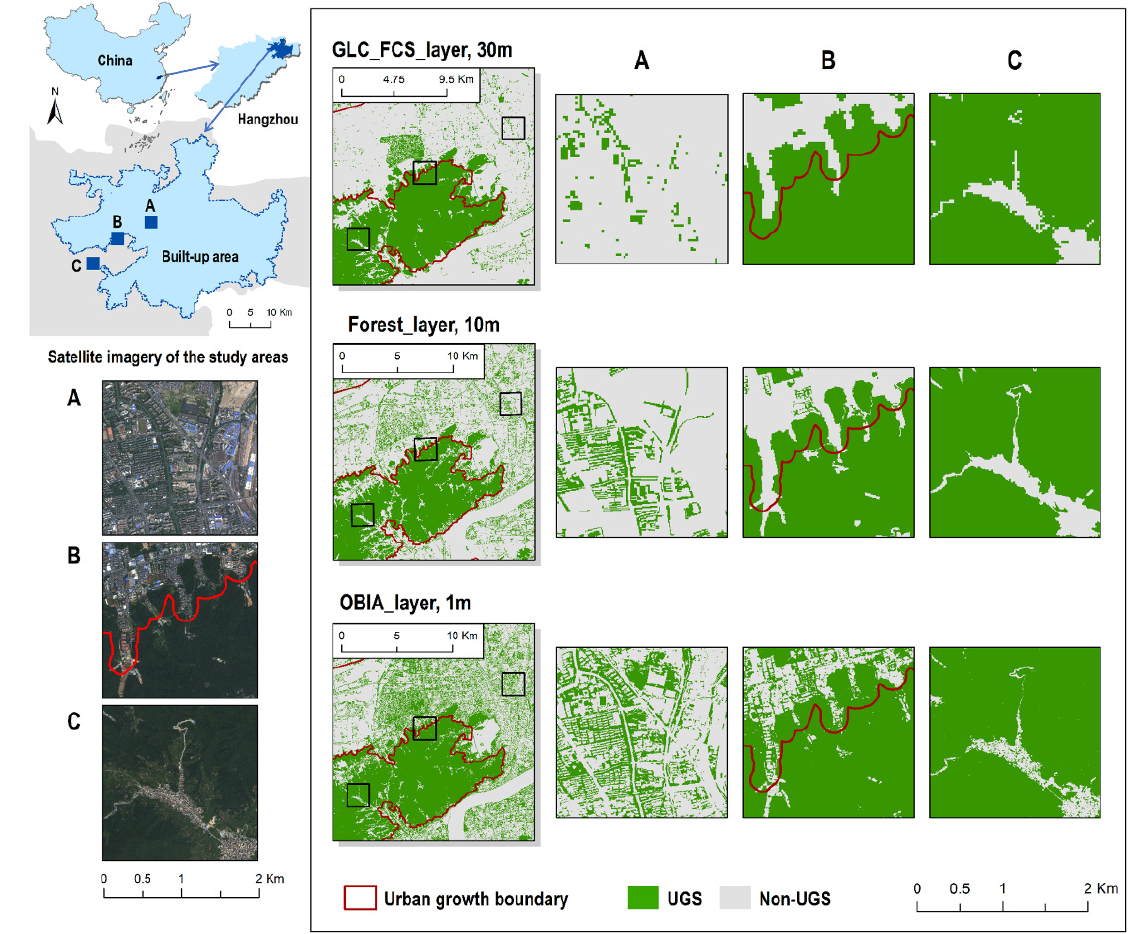
Figure 1. Three UGS maps with different spatial resolutions, i.e., GLC_FCS_layer (30 m), Forest_layer (10 m), and OBIA layer (1 m). Scenario A, B, and C are the three chosen sample study areas located in the downtown area, on the urban periphery, and in the suburban area.